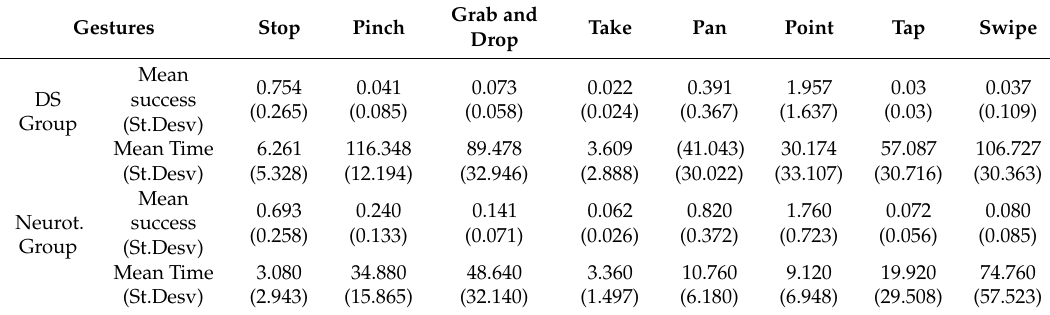
Table 3. Gestures: Descriptive statistic.